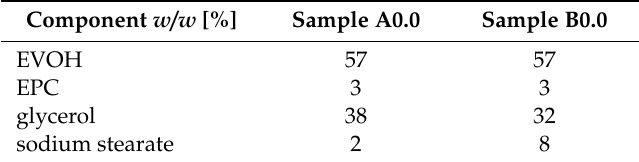
Table 2. Compositions of the prepared EVOH/EPC/glycerol/sodium stearate blends.